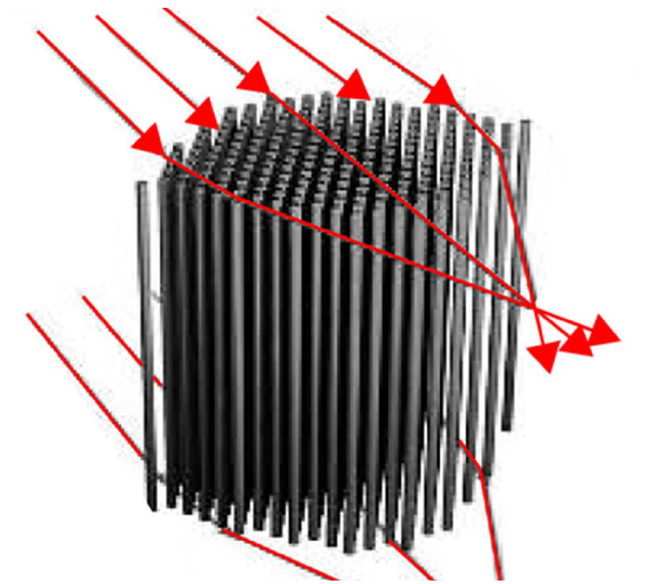
Figure 2. Scheme of sound control through the structure of a sonic crystal barrier.